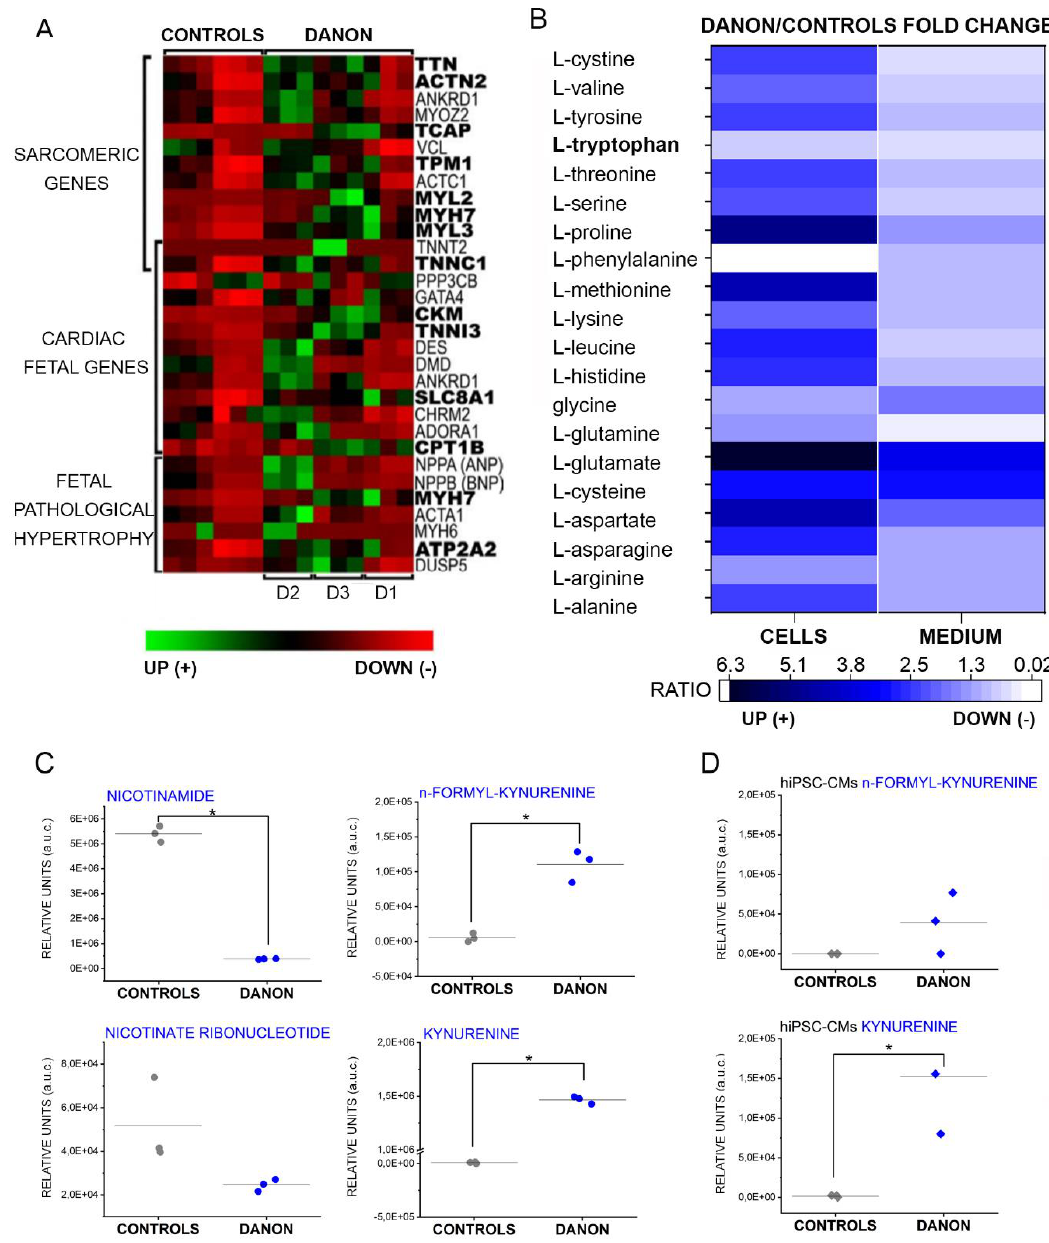
Figure 4. Transcriptomic and metabolic profiling of hiPSC-Cardiomyocytes derived from Danon patients and influence on extracellular environment. ( A ) Transcription levels of structural cardiac elements. ( B ) Amino-acids quantification: fold changes ratios between Danon and controls in the intracellular (cells) and in the extracellular (medium) compartments. ( C ) Relative concentration of nicotinate ribonucleotide and nicotinamide in the culture medium. Quantification of n-formyl- kynurenine and kynurenine in the culture medium (fold changes increase > 25; C ) in the cells (fold changes increase > 60; D ) * Significant difference p < 0.05 t -test. In line, in case of cardiac hypertrophy or senescence, NAD+ pools can be maintained also via secondary routes independent from OXPHOS [40]. Considering the crucial importance of the co-